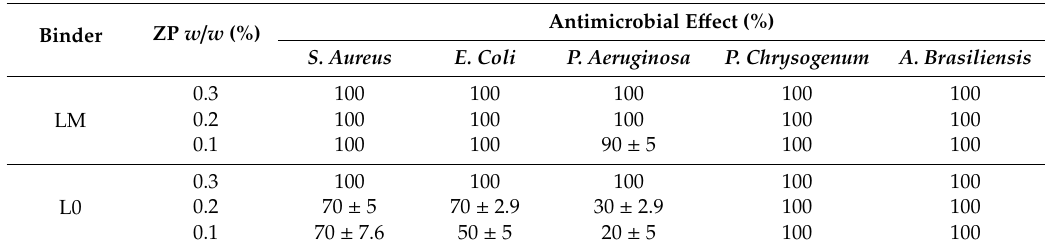
Table 11. Antimicrobial e ff ect of coating films containing zinc pyrithione (ZP). Antimicrobial E ff ect (%) Binder ZP w / w (%) S. Aureus E. Coli P. Aeruginosa P. Chrysogenum A. Brasiliensis 0.3 100 100 100 100 100 0.2 100 100 100 LM 0.3 100 100 100 100 100 0.2 70 ± 5 70 ± 2.9 30 ± 2.9 100 100 0.1 70 ± 7.6 50 ± 5 20 ± 5 100